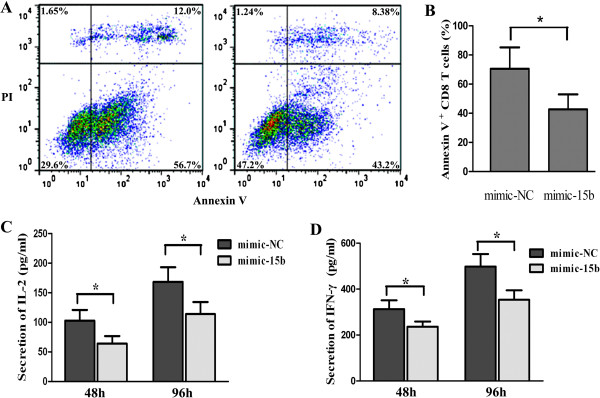
Ectopic expression of miRNA-15b protects CD8+ T cells from apoptosis and impedes the production of IL-2 and IFN-γ. A) 12 h after adding the anti-CD3 antibody, flow cytometry showed that CD8+ T cells with mimic-15b (right) displayed less apoptosis than T cells with mimic-NC (left). B) Apoptotic CD8+ T cells (which were labeled as annexin V-FITC positive) were evaluated. The result was derived from three independent assays (mean ± standard deviation). *P < 0.01. C) CD8+ T cells transfected with mimic-15b or mimic-NC were co-stimulated with CD3/CD28 mAb for 24 h and 48 h, IL-2 levels were determined by ELISA assay. Each value is the mean of 3 independent detections. *P < 0.01. D) 24 h and 48 h after co-stimulation, IFN-γ levels were determined by ELISA assay. Each value was the mean of 3 independent detections. *P < 0.01.